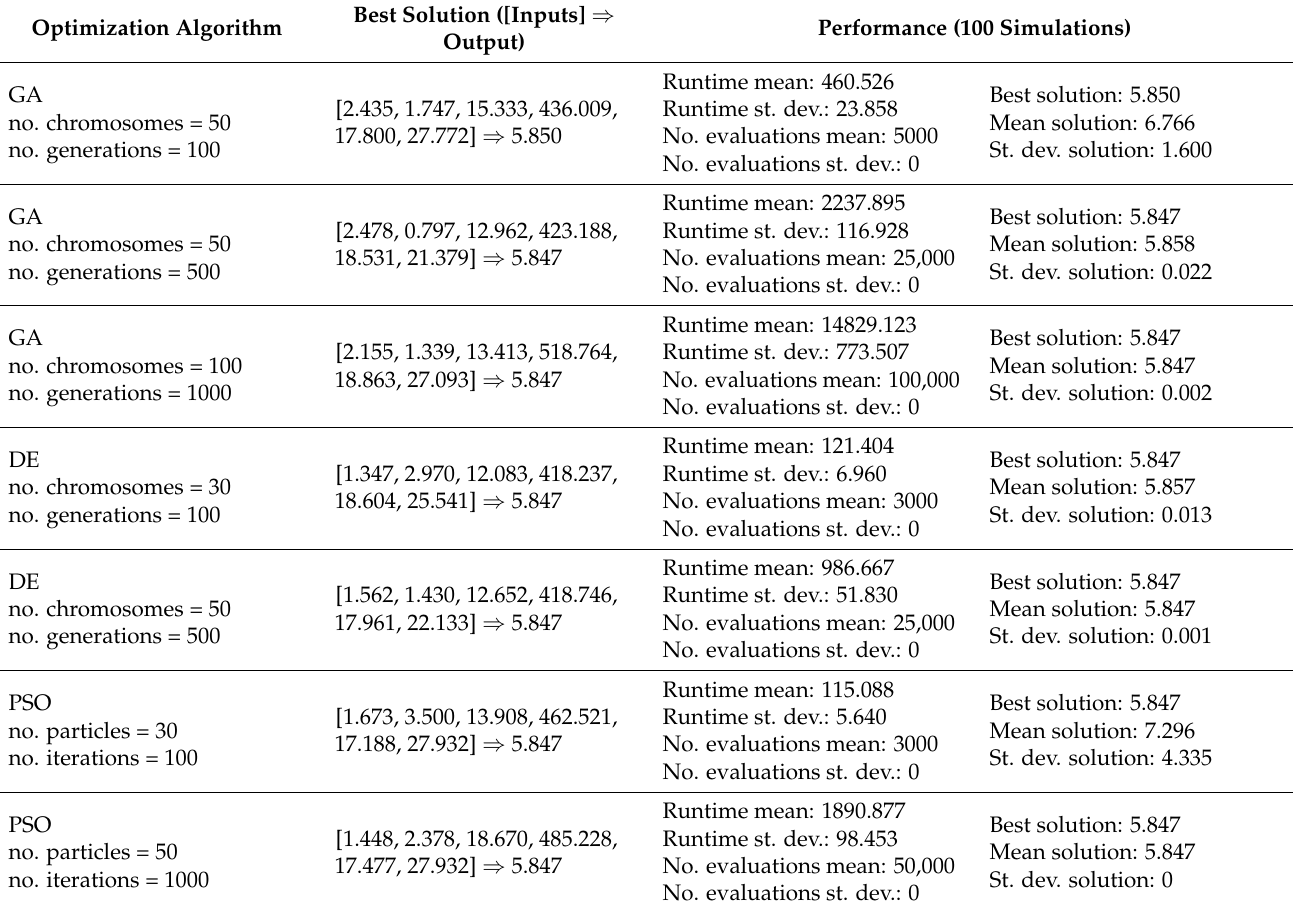
Table 6. Results obtained with classic optimization algorithms for CH4 (mg/m 3